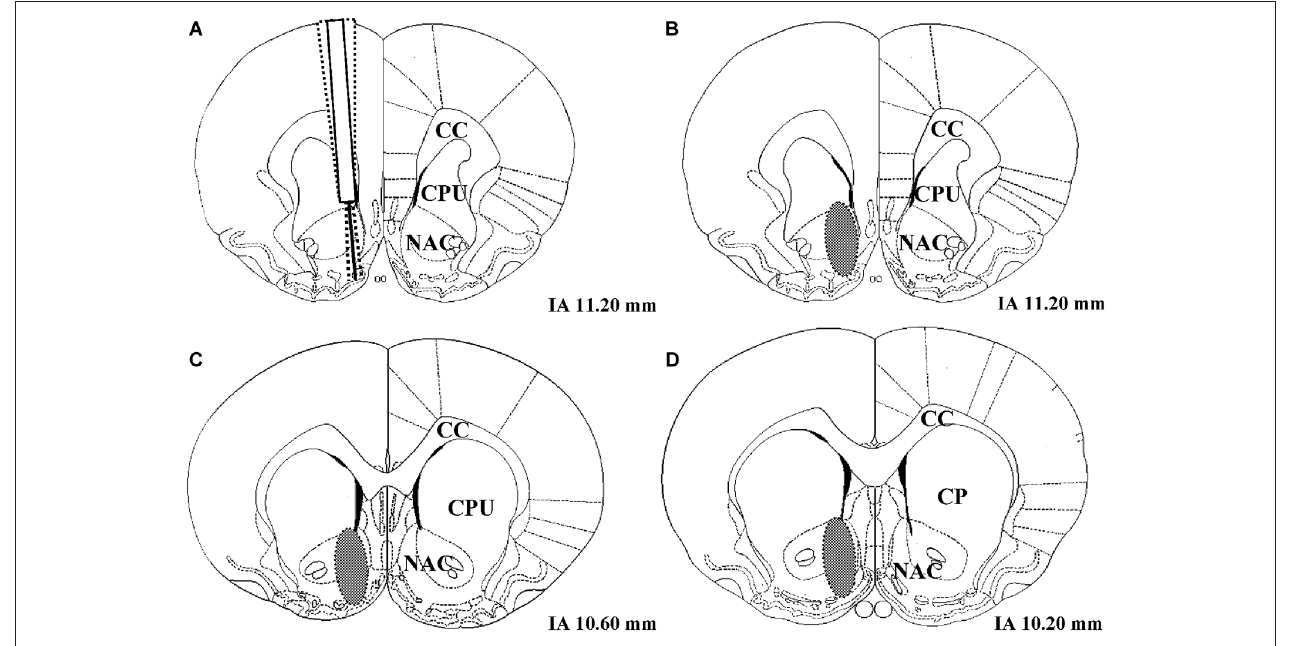
which correctly placed probes were found is indicated as a gray oval. IA corresponds to the distance (mm) from the interaural line according to Paxinos and Watson (1986), NAC = nucleus accumbens, CPU = caudate putamen, CC = corpus